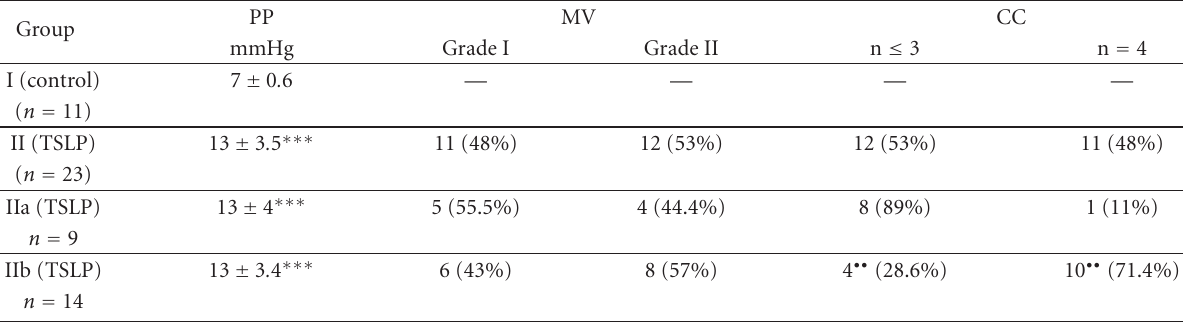
Table 2. Portal pressure (PP), mesenteric vasculopathy (MV), and portosystemic collateral circulation (CC) in control rats (Group I) and in rats with triple stenosing ligation of portal vein (TSLP) (Group II) which, in turn, were divided into Group IIa (spleen weight/body weight < 0 . 29) and Group IIb (spleen weight/body weight ≥ 0 . 30). The results are expressed as mean ± SD. ∗∗∗ denotes that P < . 001 which is a statistically significant value relative to the control group. •• denotes that P = . 005 which is a statistically significant value of Group IIb relative to Group IIa.